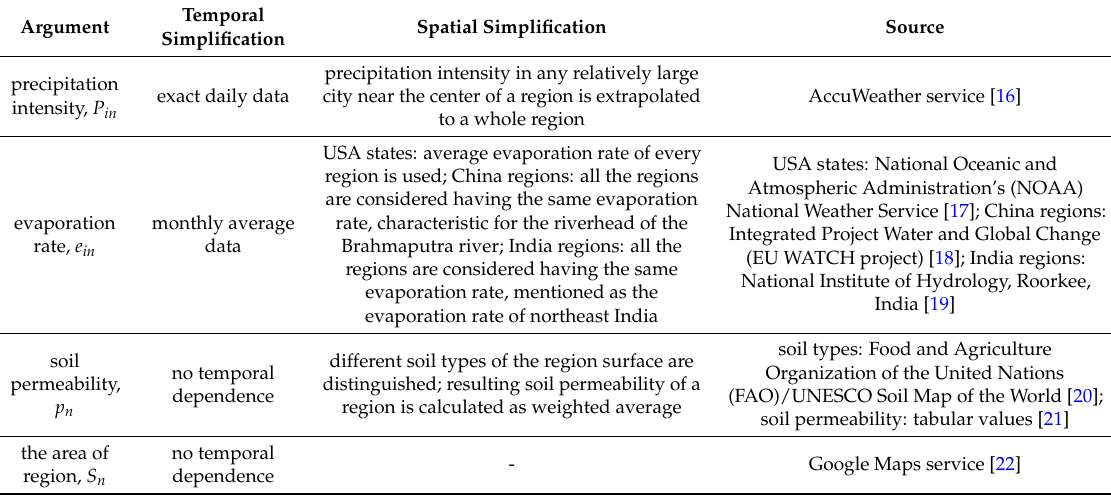
Table 1. Sources and simplification parameters of